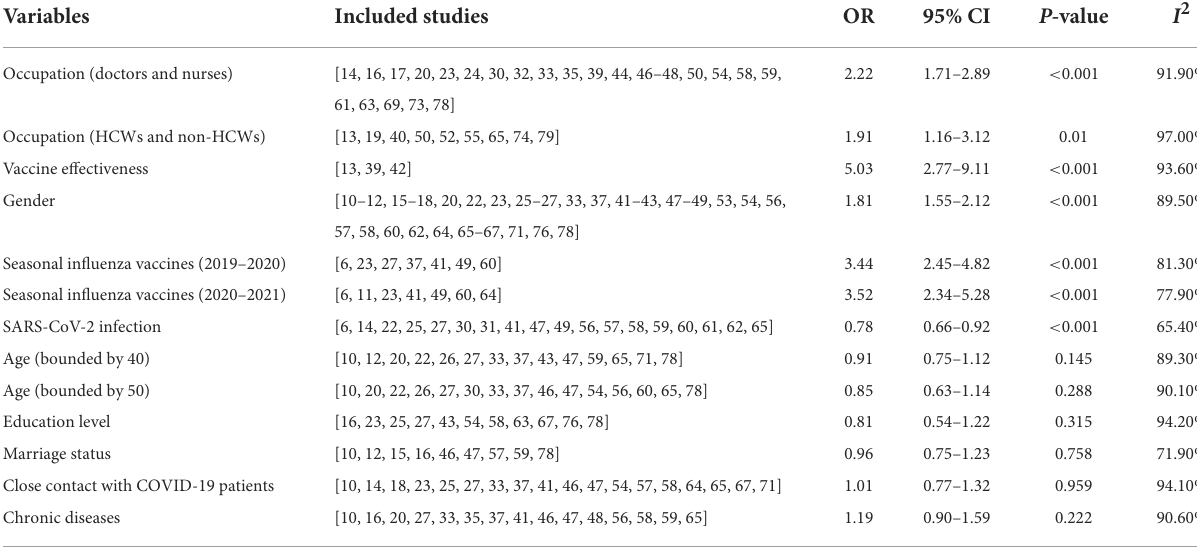
TABLE 3 The factors associated with COVID-19 vaccine acceptance of